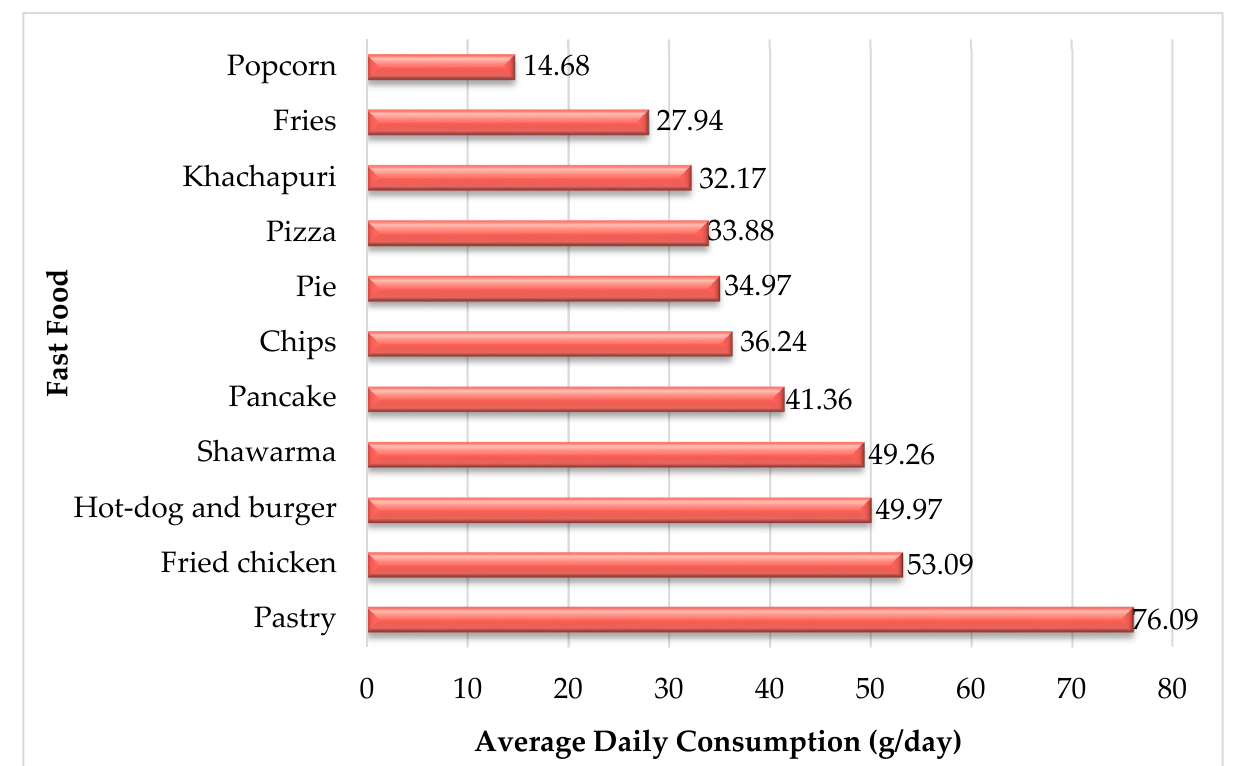
Figure 2. Average Daily Consumption of Fast-Food (g/day).